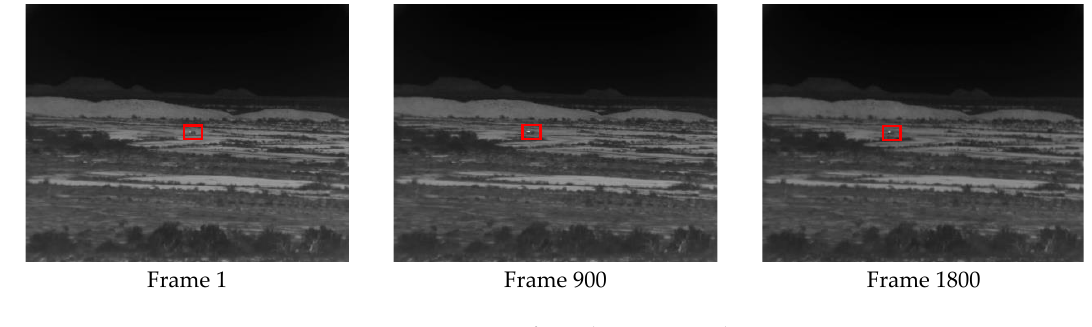
Figure 7. Frames from the 3500 m video.